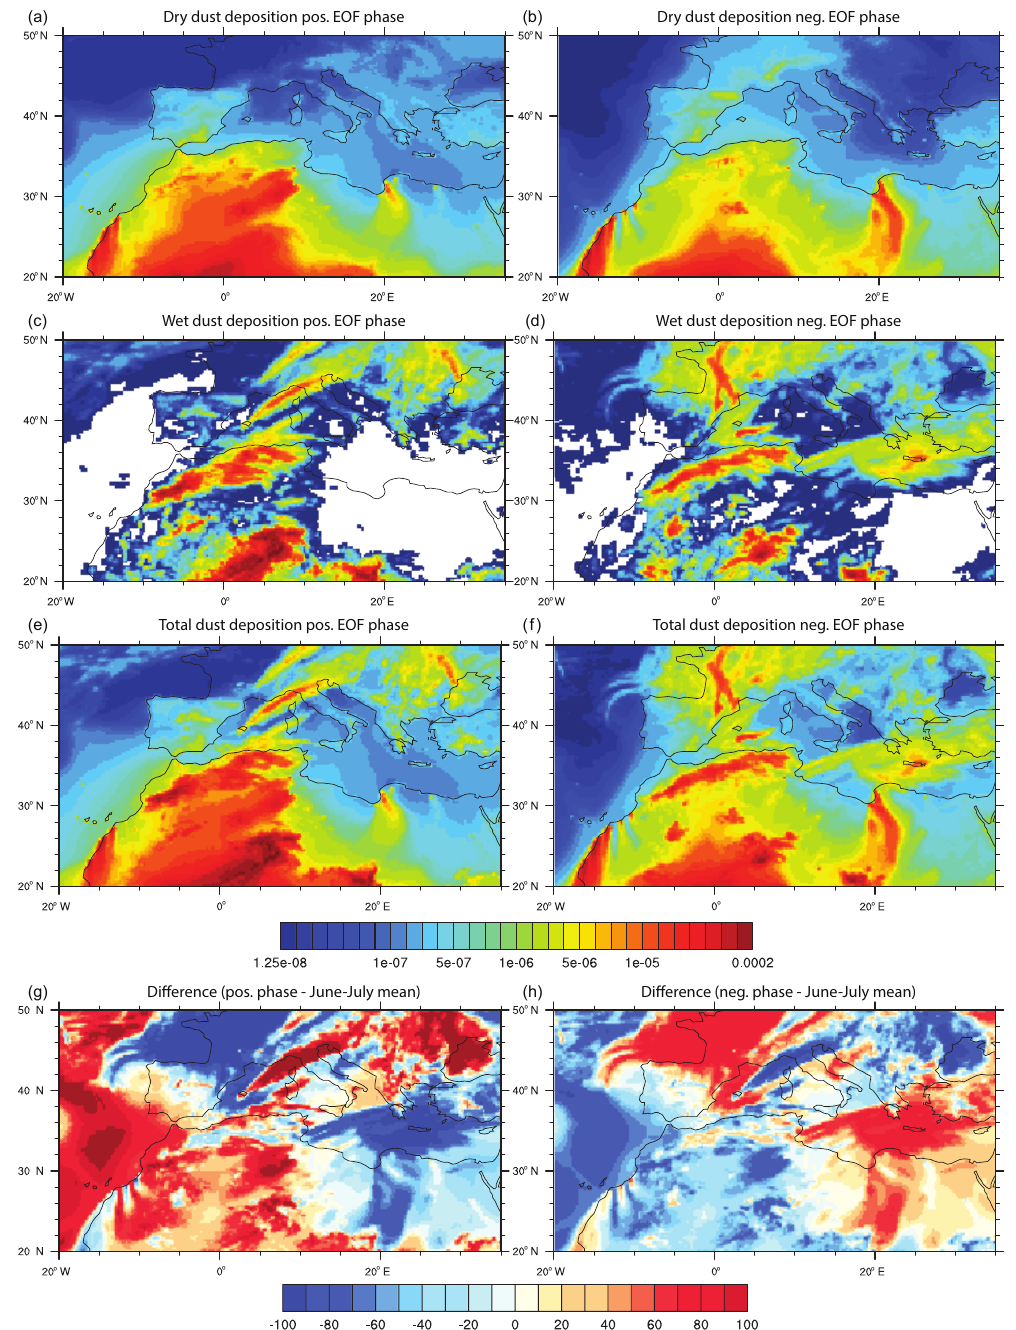
Figure 11. Composite of the dry dust deposition (kgm − 2 d − 1 ) for positive (a) and negative (b) phases of the first EOF for June–July 2013. Similar composites for wet deposition and total (dry plus wet) deposition fluxes are shown in (c) and (d) , respectively, in (e) and (f) . Panels (g) and (h) show the difference (%) of the average total dust deposition flux during (e) and (f) compared to the June–July 2013 mean.